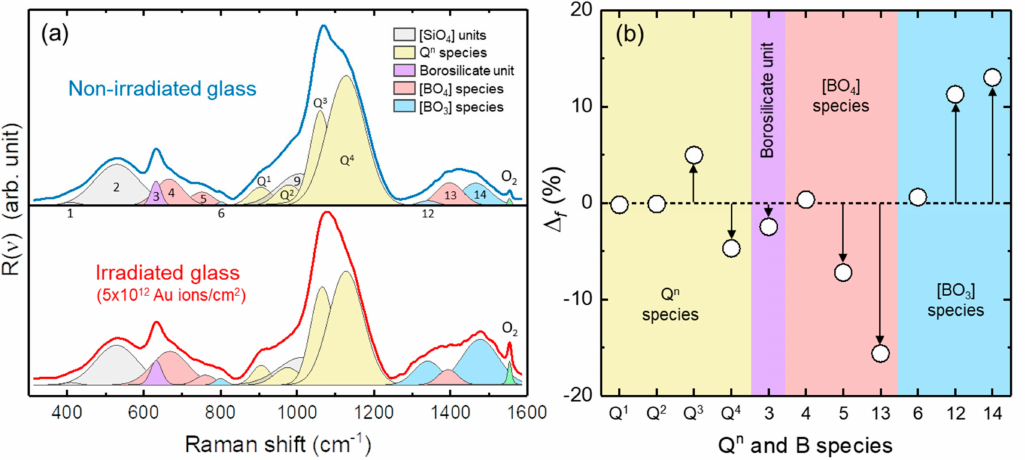
Figure 4. ( a ) Representative background-corrected R ( ν ) Raman spectra (average of 10 individual spectra) from the non-irradiated glass (upper spectrum) and the irradiated surface layer (lower spectrum) of the ternary Na borosilicate glass (TBG) used in this study for dissolution experiments along with the result of a least-squares fit with 15 Gauss–Lorentz functions. The assignment of the Raman bands to a vibrational mode of a structural glass unit and to O 2 is indicated by colored Gauss-Lorentz profiles. The di ff erent glass bands are labeled by numbers and by the Q n notation in the cases of the stretching motions of [SiO 4 ] groups with n = 1, 2, 3, or 4 bridging oxygen atoms. Note the significantly higher intensity of the O 2 band near 1555 cm − 1 in the spectrum from the irradiated sample. ( b ) Diagram showing the di ff erence, ∆ f = f irr − f non-irr , between the intensity fraction of di ff erent silicate- and borate-related bands of the irradiated, f irr , and non-irradiated, f non-irr , TBG. The fractions were determined from the integrated intensities and the intensity sum of the respective Raman bands that are shown and labeled in Figure